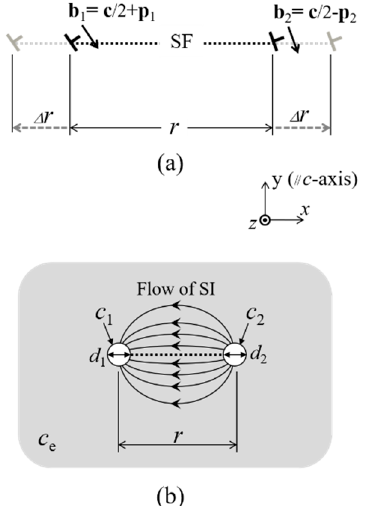
Figure 7. Dissociation of a sessile perfect dislocation. ( a ) Climb motion of Frank–Shockley partials b 1 ( = c / 2 + p 1 ) and b 2 ( = c / 2 − p 2 ), with p 1 − p 2 = a 3 (Figure 1c), in a basal plane that dissociated from a perfect dislocation < c + a > , with stacking fault (SF) lying in between. They move apart due to a mutually repulsive force. ( b ) A self-interstitial (SI) flow model for the dissociation process. The partials b 1 and b 2 are replaced by cylinders of diameters d 1 and d 2 embedded in infinite medium. SI flow occurs from cylinder 2 to 1, driven by a difference in SI concentrations C 1 (< C e ) and C 2 (> C e ) at the cylinder surfaces, where C e is the equilibrium concentration at temperature T .